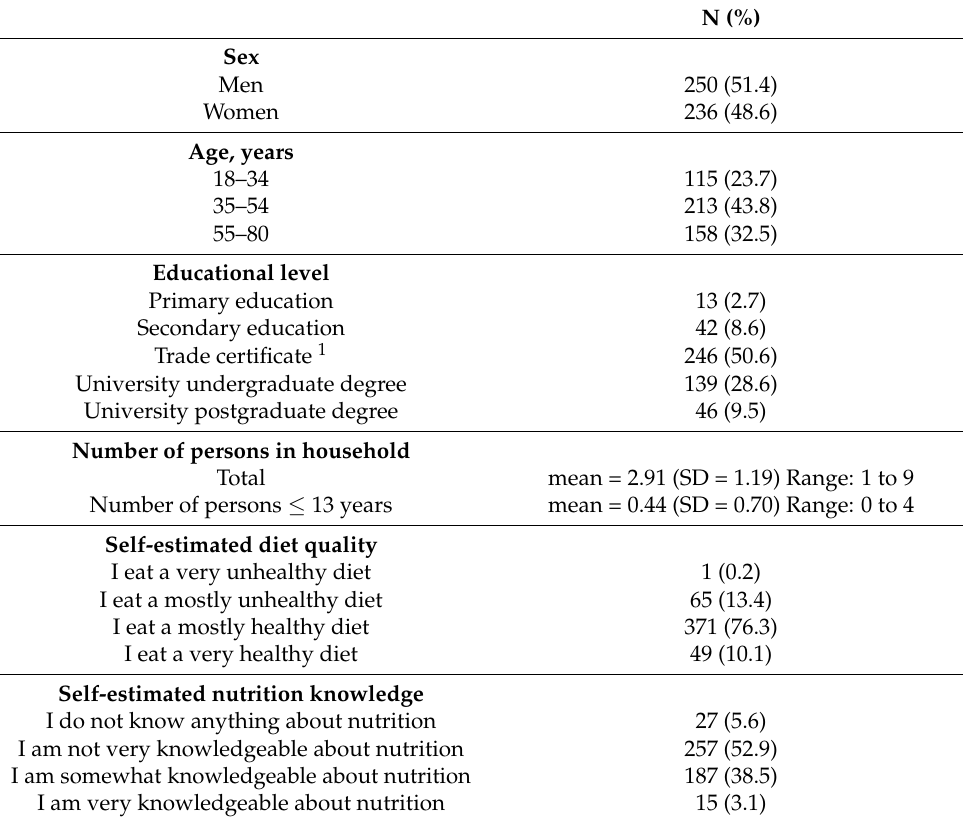
Table 1. Individual characteristics of the study sample (N =